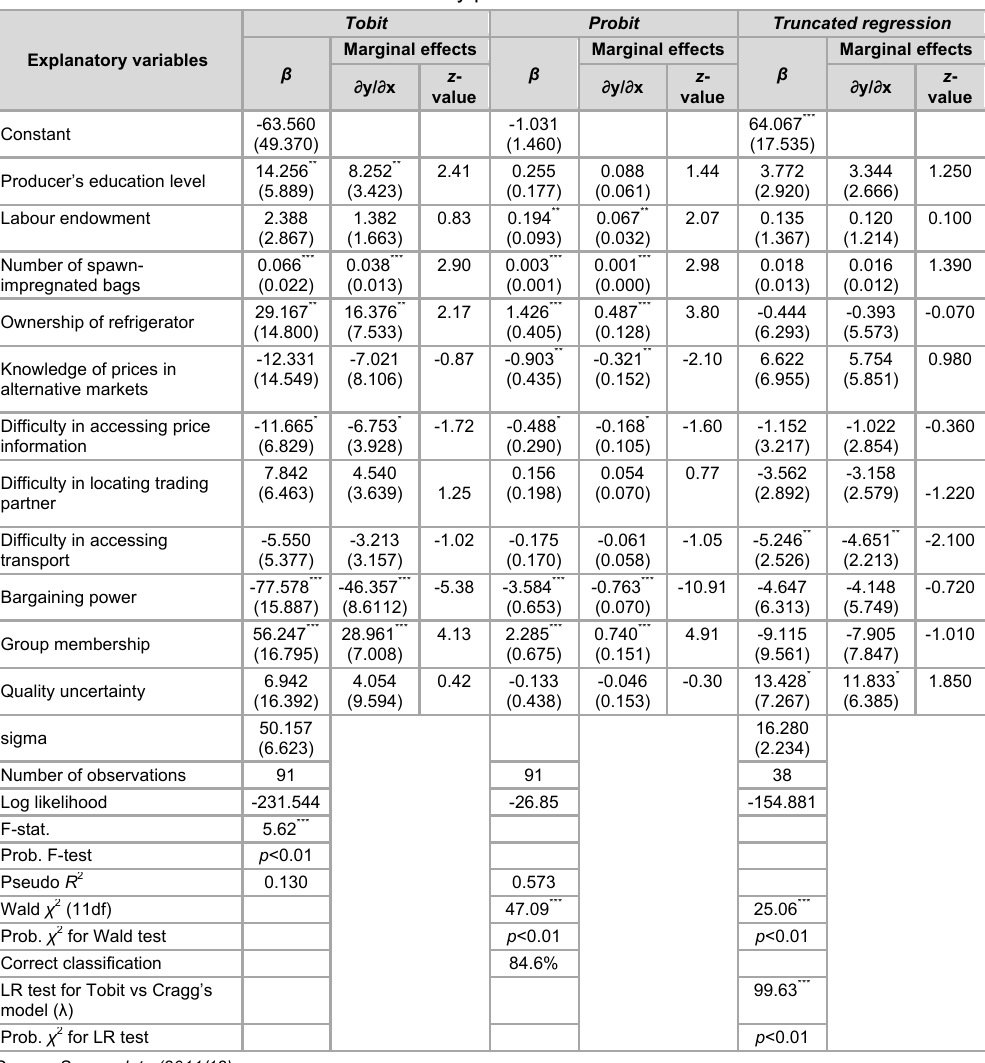
Regression results for factors influencing choice of marketing channel and proportion of mushrooms sold by producers in